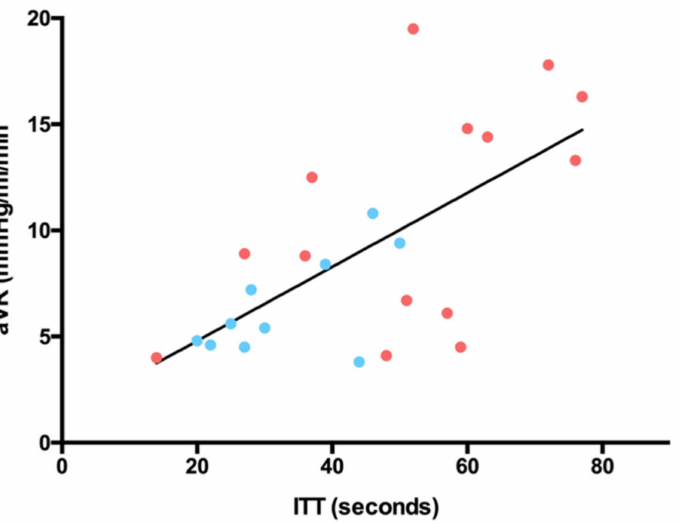
Figure 6. Arterial Vascular Resistance (aVR, mmHg/mL/min) versus Intrinsic Transit Time (ITT, seconds); y = 0.1744x + 1.308; p = 0.0006; r2 = 0.4196; red dots = DIEP flaps; blue dots = ms-TRAM